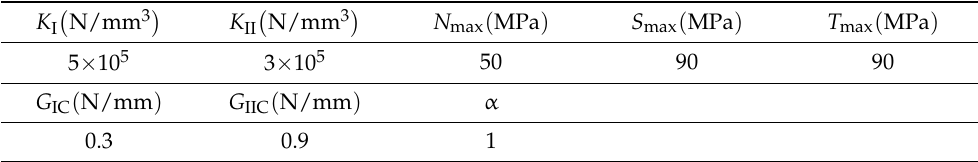
Table 3. Material parameters of the cohesive